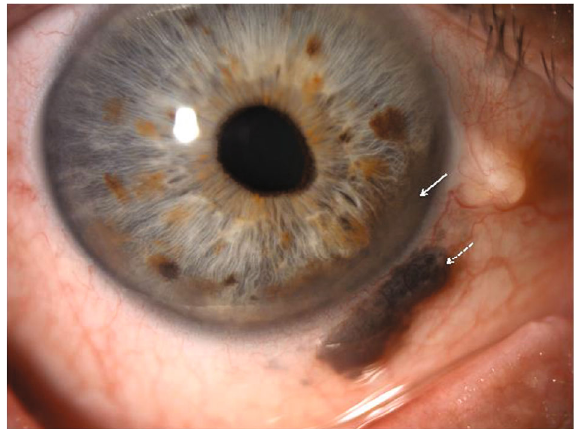
Figure 1: A slit-lamp photo revealing a pigmented iris mass (white arrow) with an extrascleral spread (dashed arrow).